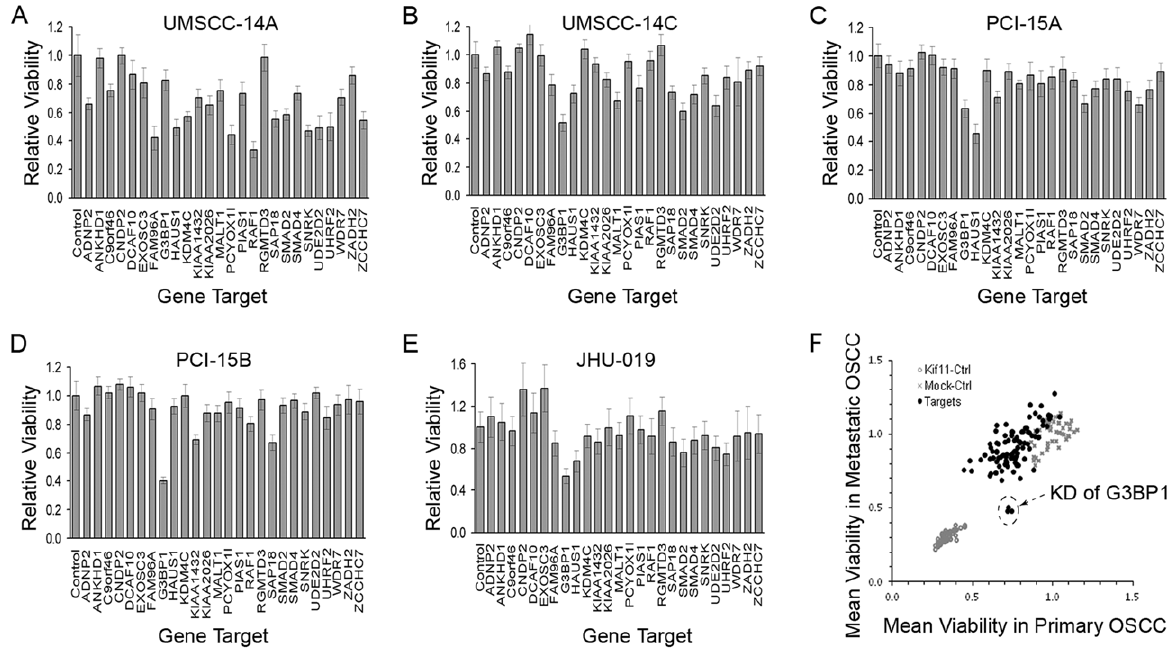
Figure 3. Results of siRNA knockdown screen. (A–E) Cell viability after the siRNA-mediated gene knock-down (KD) screen in UM-SCC-14A, UM- SCC-14C, PCI-15A, PCI-15B, and JHU-019. Cell viability was measured 4 days after the siRNA transfection. Results were presented as relative to control cells treated with transfection reagent only. Error bar represent the standard deviation of 9 repeats; (F) Average viability in cell lines derived from primary OSCC (x-axis) and from metastatic OSCC (y-axis). KD of Kiff11 and transfection reagent only was used as positive and negative control. Arrow indicates the three repeats of KD of G3BP1.